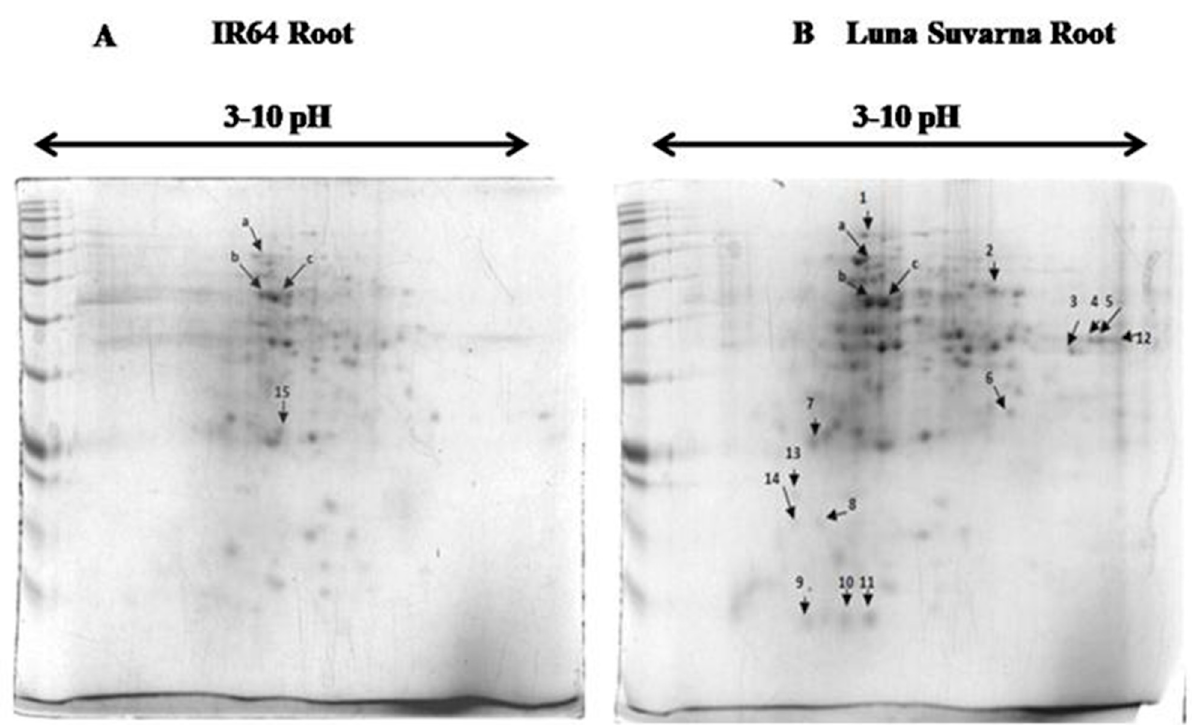
8 of 22 Figure 2. Real-time gene expression analysis of auxin homeostasis genes under control and salinity stress conditions in IR64 and LS roots. ( A ) Real-time gene expression of auxin biosynthesis genes; ( B ) Real-time gene expression of auxin transport genes; ( C ) Real-time gene expression of auxin conjugation and degradation genes; ( D ) Real-time gene expres- sion of auxin receptor genes; ( E ) Real-time gene expression of auxin signaling genes. Three biological replicates were taken and bars represent mean ± SE. Asterisks signs (*, **, ***) represent values which were significantly different among different samples (Fisher LSD, p ≤ 0.05). The transcript levels of LS under normal condition and, LS and IR64 upon salinity stress treatment were compared with IR64 (control), whose expression was assumed as 1. (-NaCl) refers to untreated samples, (+NaCl) refers to salinity treated samples. Blue color refers IR64 root (-NaCl), red color refers to LS root (-NaCl), green color refers to IR64 root (+NaCl), and purple color refers to LS root (+NaCl). 2.3. 2-DE Analysis of Root Proteins in IR64 and LS In complement to auxin-related gene expression analysis, the proteins isolated from roots of 14-days old seedlings of salt-sensitive IR64 and salt-tolerant LS cultivars of rice were subjected to 2-DE analysis. A total of 146 spots were detected in IR64 while 166 spots were observed in LS (Figure 3), using PDQuest 8.0.2 software. Among these protein spots, 27 were observed to be either present/absent and few were of altered intensity in the roots of IR64 and LS. These spots were excised and sent for MALDI TOF/TOF MS/MS analysis. Out of 27 spots, only 18 proteins were successfully identified (Tables 1 and 2). The plant intracellular Ras group related LRR protein 2, B3 domain-containing pro- tein,and Ubiquitin fold modifier protein 1 displayed higher protein expression by 1.76, 1.1, and 3.75 fold in the roots of LS in comparison to IR64, respectively (Table 2). Among